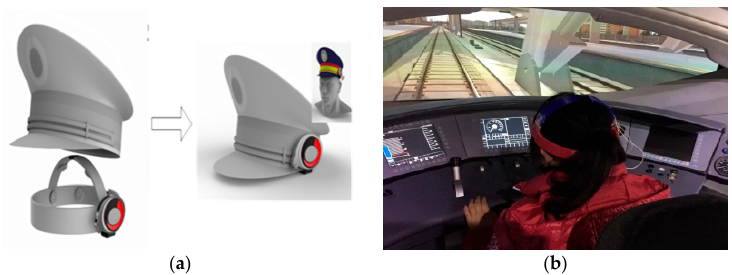
Figure 3. 10–20 electrode system.